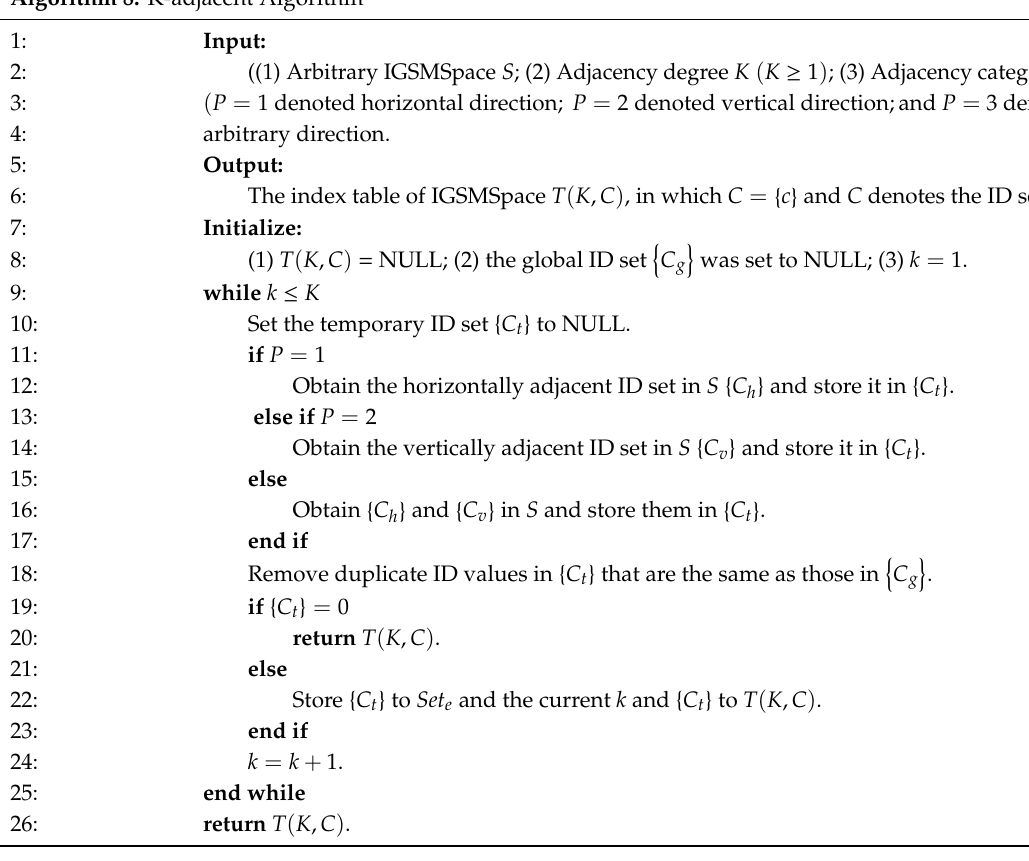
Algorithm 8. K-adjacent Algorithm